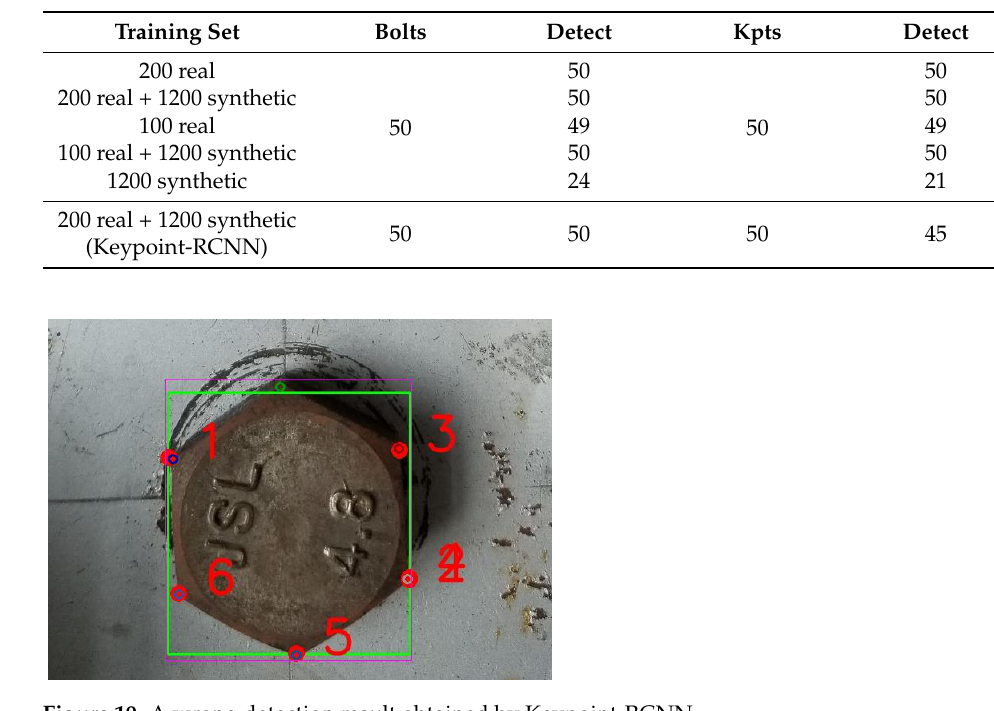
Table 5. Evaluation results of bolt and bolt corner point detection for the test set.